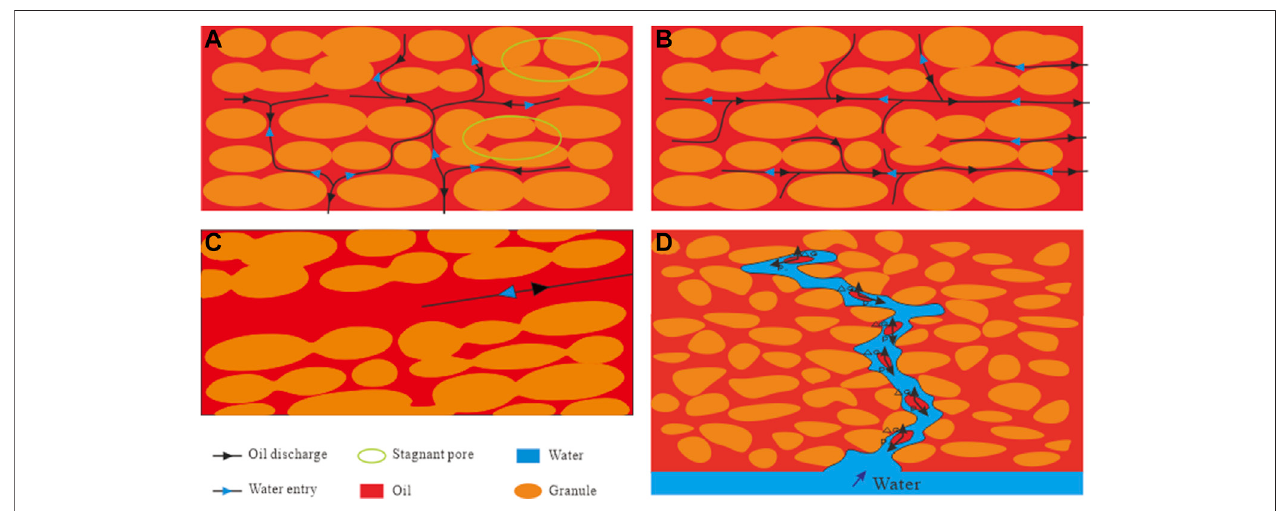
FIGURE10| Imbibitionpatternofbeddingfractures (A) andoftectonicfractures (B) andgravity(buoyancy)effectonimbibitionresponse (C) andreverseimbibition pressure in the lower part of rock matrix (D) .